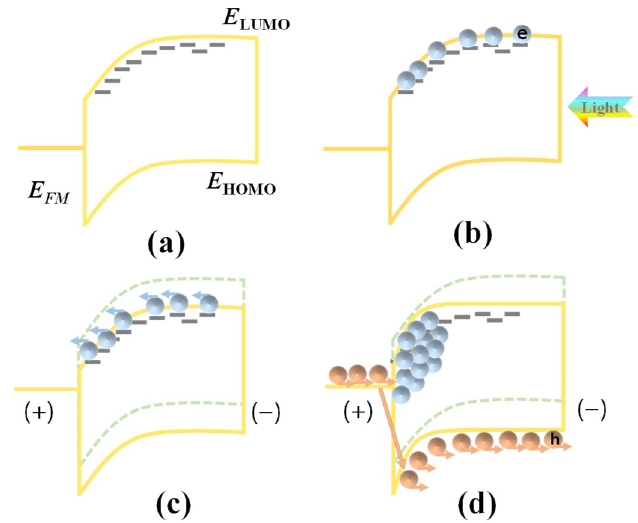
Figure 2. Working mechanism of organic photomultiplication (PM) photodetectors due to the electron trap assisted hole tunneling effect. ( a ) Energy band bending without bias; ( b ) Photo-generated electrons are captured by traps; ( c ) Trapped electrons transport toward the junction once the bias is applied; ( d ) Trapped electrons arriving at the junction cause the hole tunneling from the circuit into the semiconductor, producing the current multiplication effect. E FM is the Fermi level of the metal, and E LUMO and E HOMO are the lowest unoccupied molecular orbital level and the highest occupied molecular orbital level of the organic semiconductor, respectively.